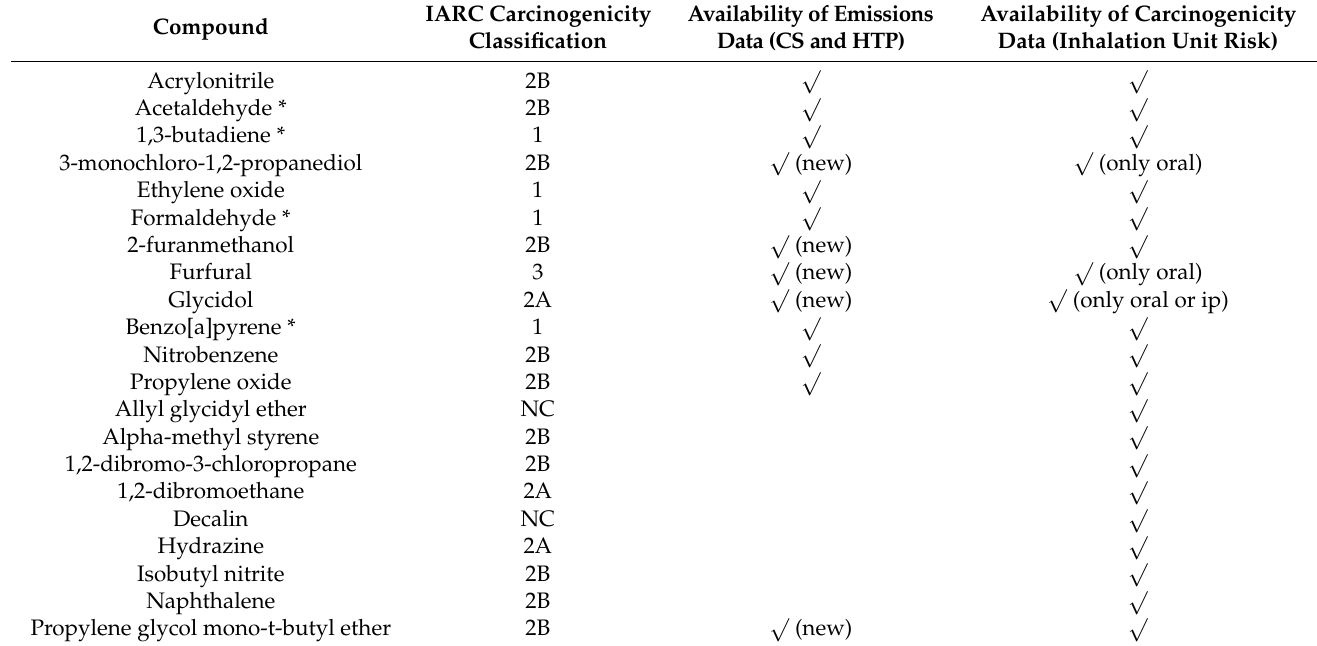
Table 1. Inventory of compounds in cigarette smoke (CS) or heated tobacco product (HTP)